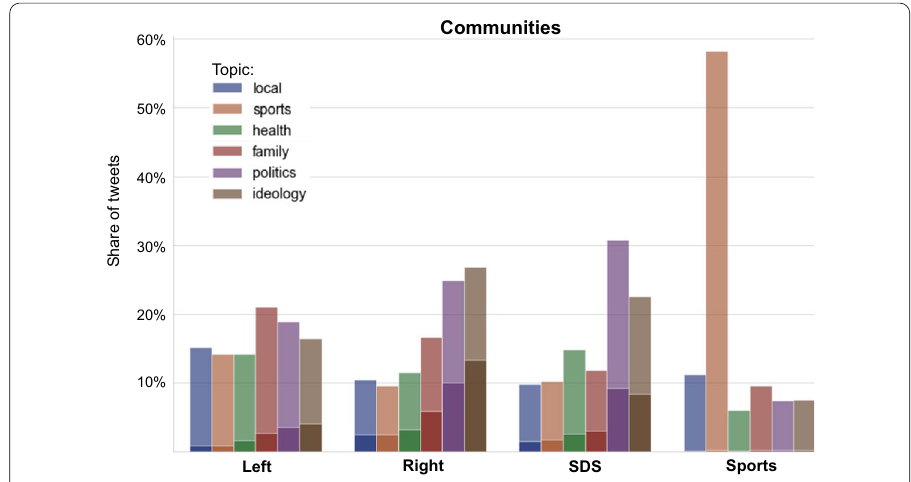
Fig. 4 Cumulative topic distribution for the four major communities: Left, Right, SDS, and Sports. Darker areas represent fractions of unacceptable tweets in individual